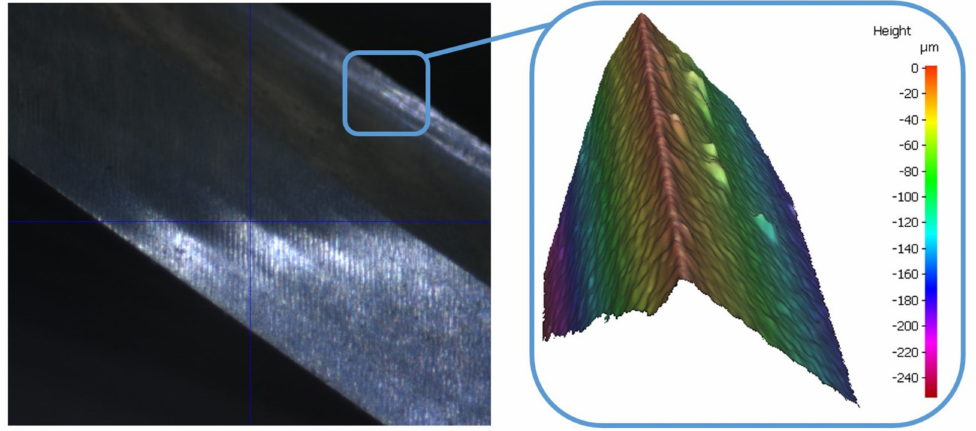
Figure 2. Micro-rounded mill cutting